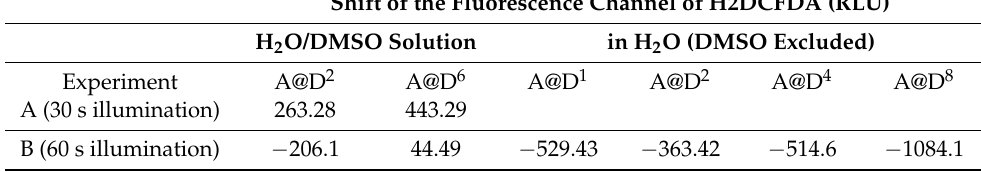
Table 1. Shift of the mean fluorescence channel of A@D 1 , A@D 2 , A@D 4 , A@D 8 (aqueous/DMSO solution), and A@D 2 and A@D 6 (in aqueous solution) dendrimers in relation to conjugates with- out ALA (D 1 , D 2 , D 4 , D 8 , and D 2 and D 6 , respectively). The parameters of cell illumination were: (A) λ = 655 nm, E = 137 mW/cm 2 , H = 4.1 J/cm 2 , and (B) λ = 655 nm, E = 137 mW/cm 2 , H = 8.2 J/cm 2 . Excitation wavelength was 488 nm; fluorescence was detected at 530 nm. Shift of the Fluorescence Channel of H2DCFDA (RLU) H 2 O/DMSO